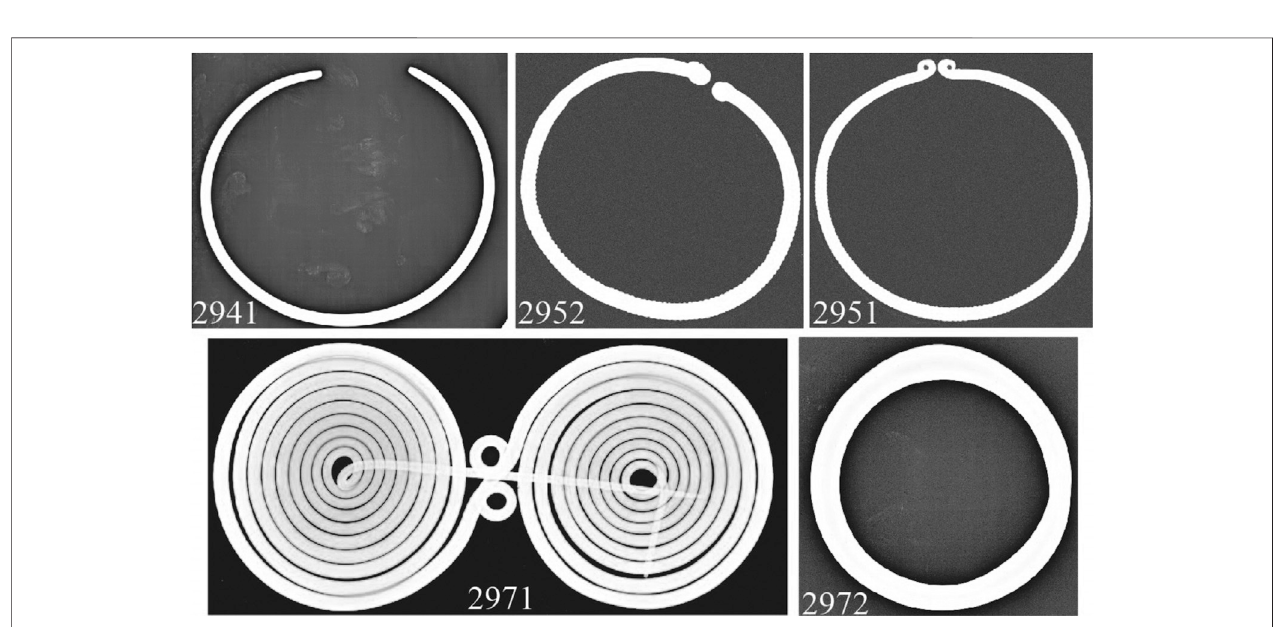
FIGURE 4 | (A) photograph of the metal hoard Cx116; (B)